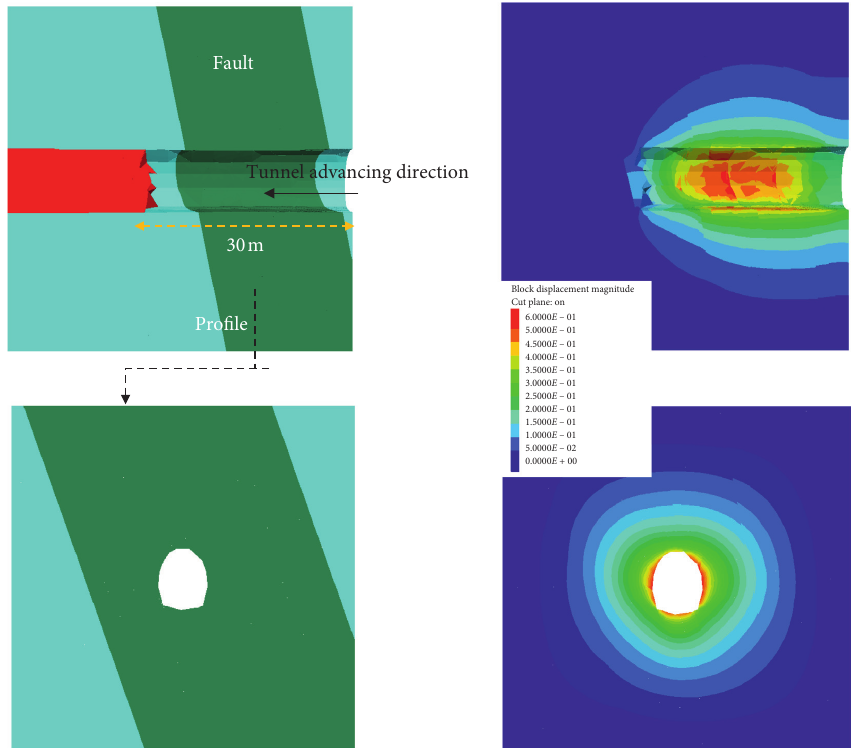
Figure 6: The range of the tunnel into the fault is